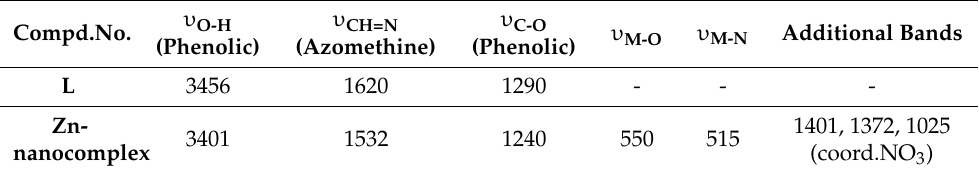
Table 3. Infrared spectral data of free ligand and its metal